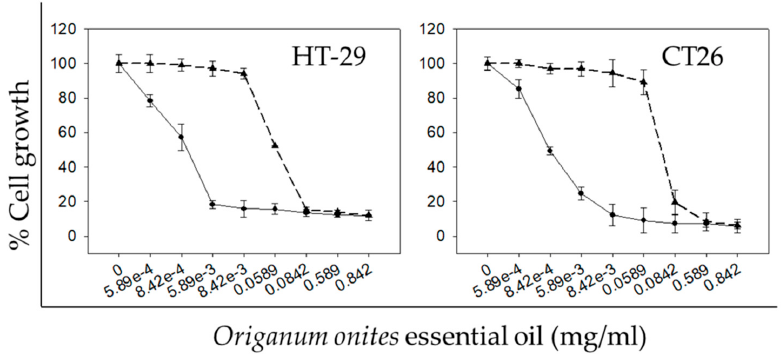
Figure 1. In vitro anticancer activity of OOEO against human cancer cell lines . Antiproliferative effect of increasing doses of OOEO at 72 h on human skin melanoma A375 cells, breast cancer MCF-7 cells, hepatocellular carcinoma HepG2 cells, and colon cancer HT-29 cells. Cell growth percentage was analyzed with the sulforhodamine B (SRB) assay. All data shown are representative of at least three independent experiments. Values represent mean ± SD.